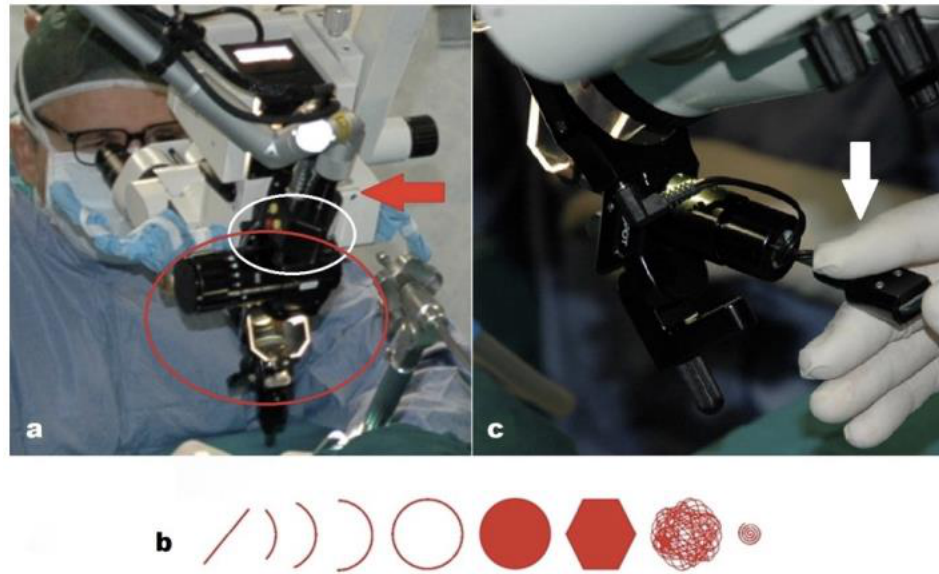
Figure 2. ( a ) Micromanipulator (red ellipse). Surgical scanner (white circle). Connection to the laser arm (red arrow). ( b ) Scanning shapes. ( c ) Joystick (white arrow) with the microswitch on top of the handle.